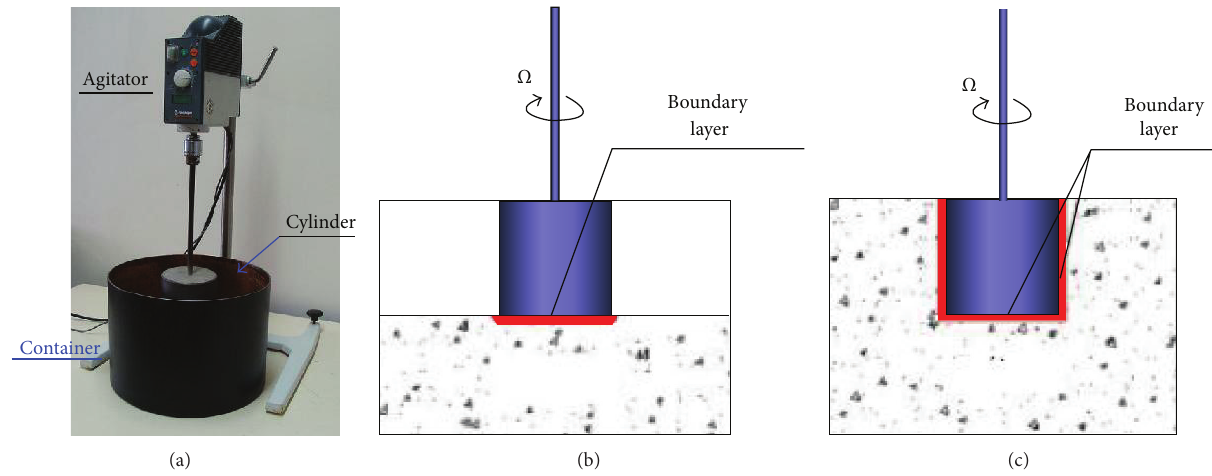
Figure 3: Components of the tribometer and test procedure: (a) tribometer set up; (b) measurement at Step 1; and (c) measurements at Step 2 as proposed by Ngo